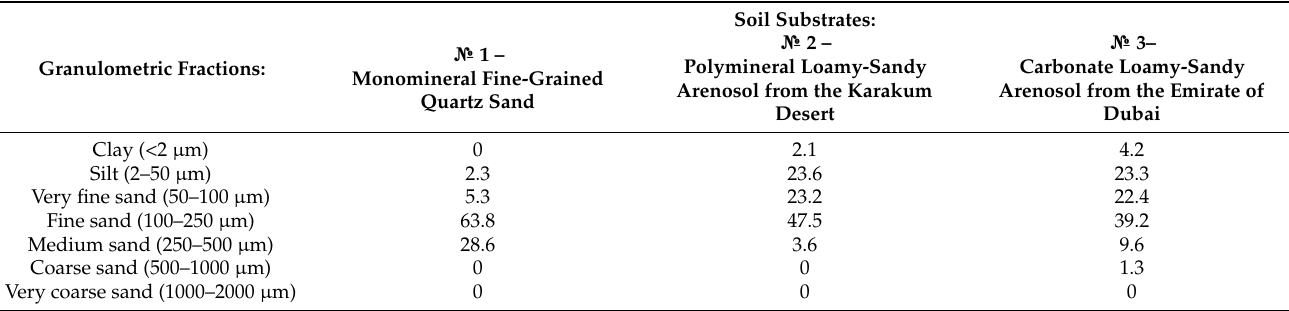
Table 1. Granulometric composition of mineral soil